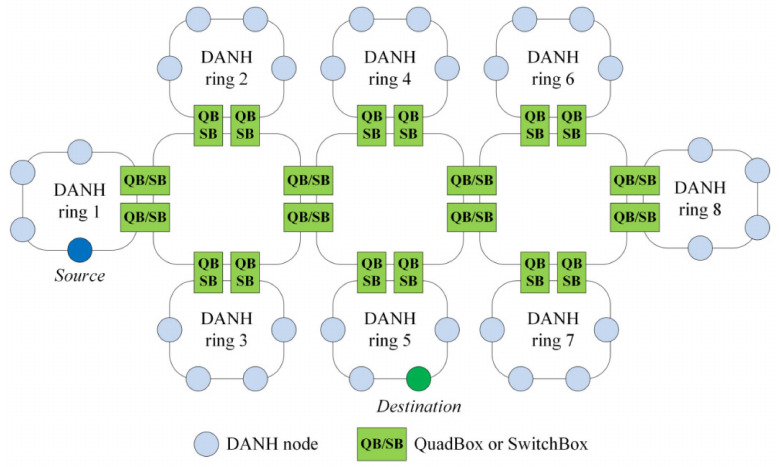
Figure 18. A sample HSR